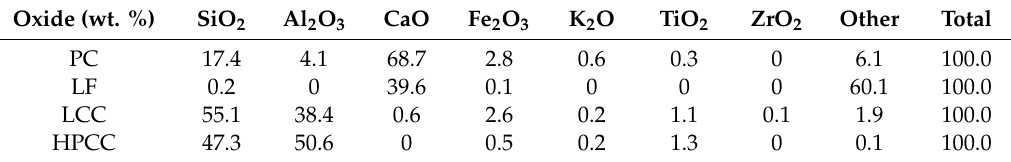
Table 2. Reactivity of low-grade calcined clay (LCC) and high-grade calcined clay (HPCC) (wt.